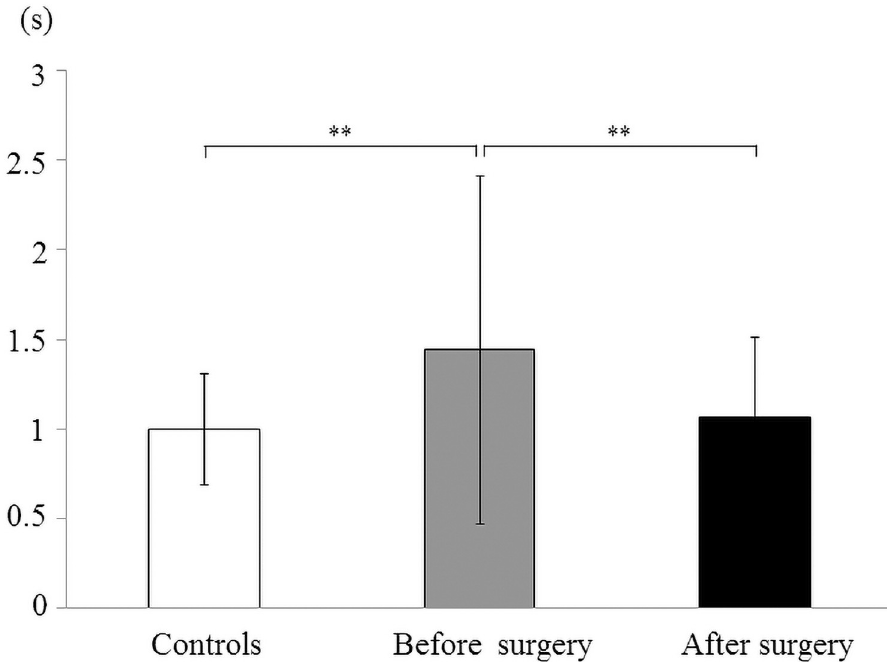
Fig 7. Mean and standard deviation in the duration of swallowing phase in the controls and patients with mandibular prognathism before and after surgery. The duration of the oral and pharyngeal phase ( �� : p < 0.01).